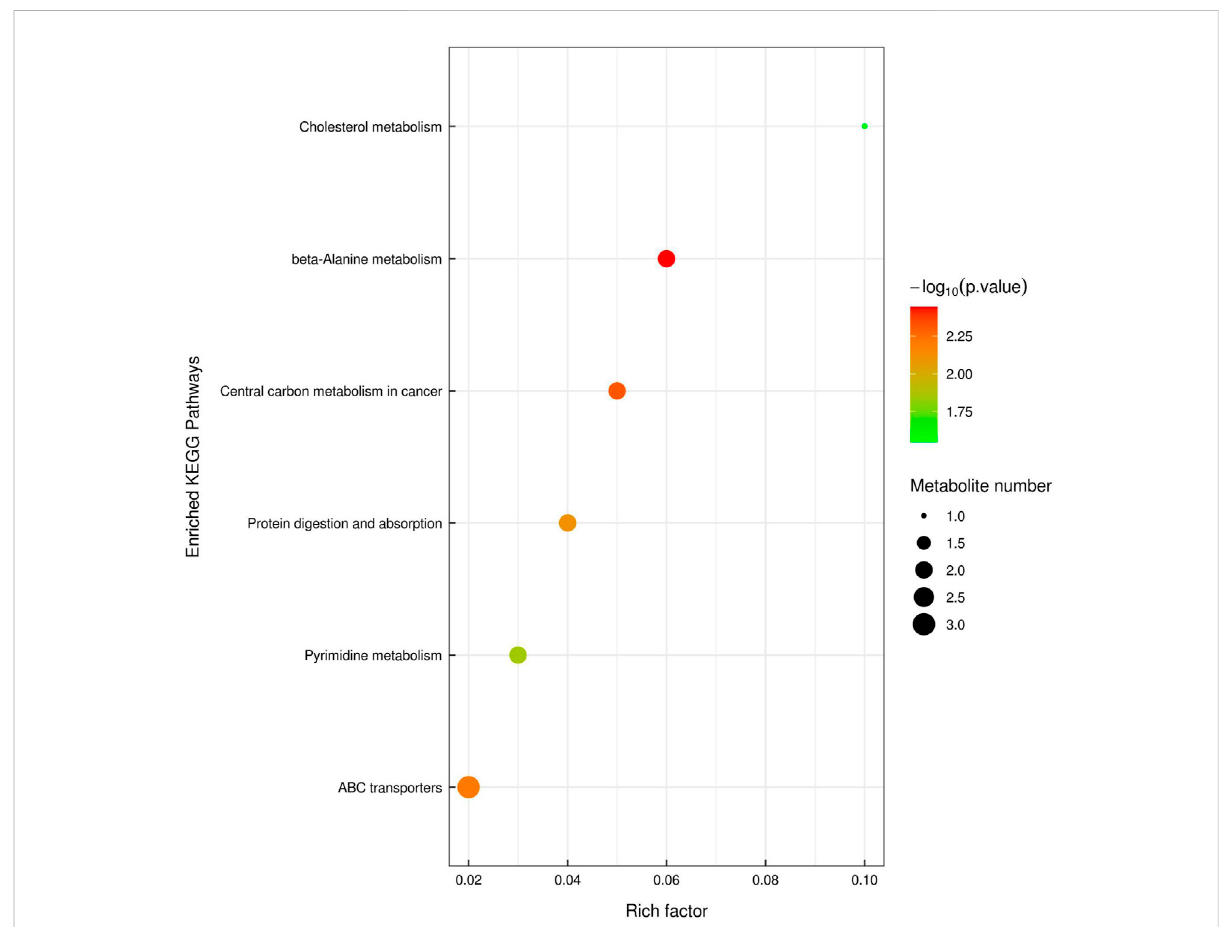
FIGURE 2 KEGGpathwayenrichmentanalysis ofthose 37signi fi cantly changed tissue metabolites. The colorofthe pointrepresented p -valueand itssize indicated the number of different metabolites enriched. The value of rich factor represented the ratio between the number of different metabolites and the total metabolites in each